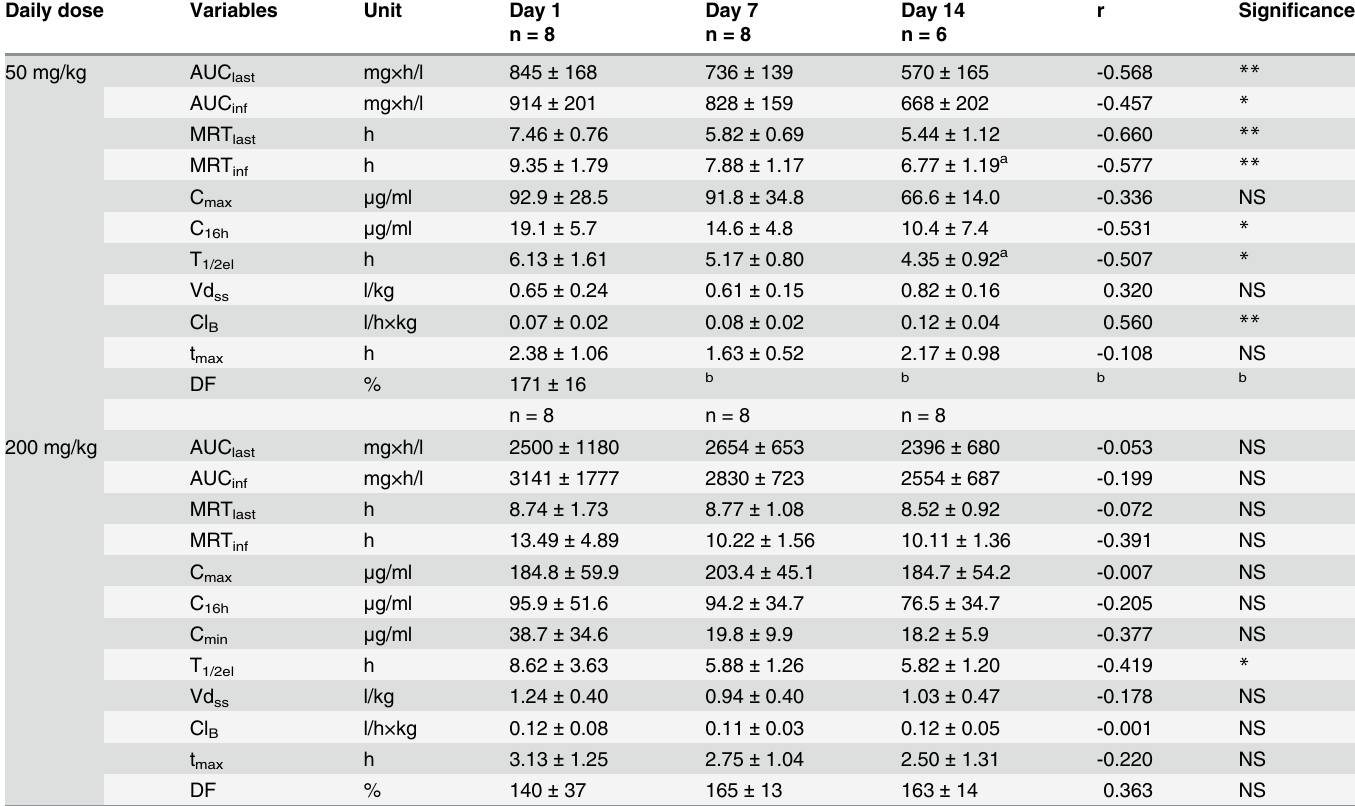
Table 1. Pharmacokinetic variables (mean ± SD) of salicylate (SA) calculated from 3 subsequent experiments during two-week sodium salicylate (SS) oral administration in laying hens. Daily dose